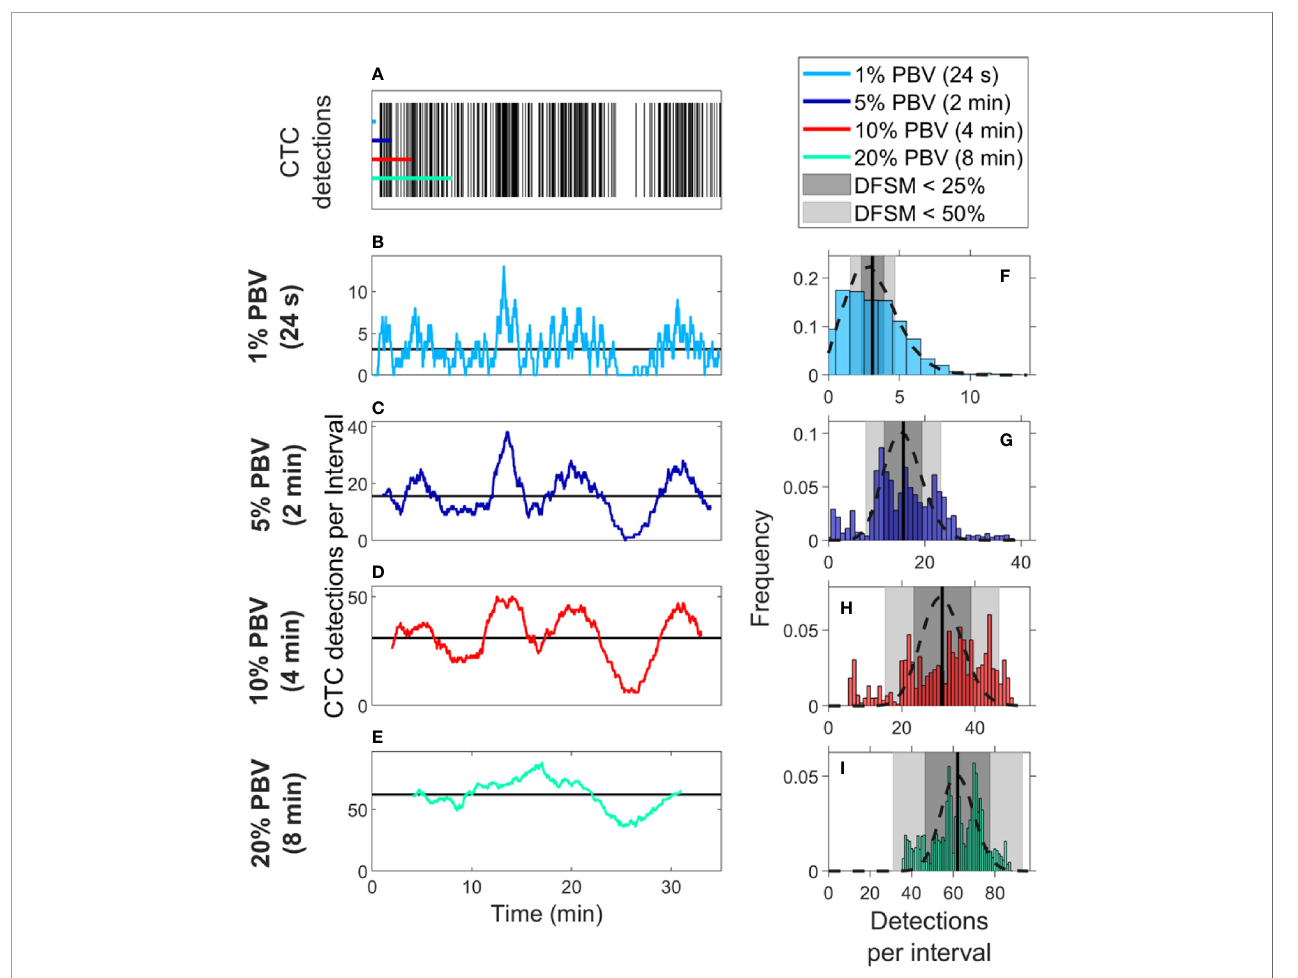
FIGURE 3 | Signi fi cant temporal fl uctuation in CTC numbers were observed over the timescale of minutes. (A) Representative DiFC raster plot measured from a MM DXM bearing mouse. Colored horizontal lines show the length of each time interval (blood sample size). The number of CTCs counted in sliding (B) 1%, (C) 5%, (D) 10%, and (E) 20% equivalent PBV intervals are shown. Black horizontal lines identify the scan mean number of CTCs per interval. (F – I) The corresponding distributions of CTC counts for each equivalent PBV are shown. Black dashed lines indicate the distributions that would be expected from Poisson statistics. Black vertical lines show the mean number of CTCs. Gray shading denotes the range of DFSM < 25% (light gray) and < 50% (dark